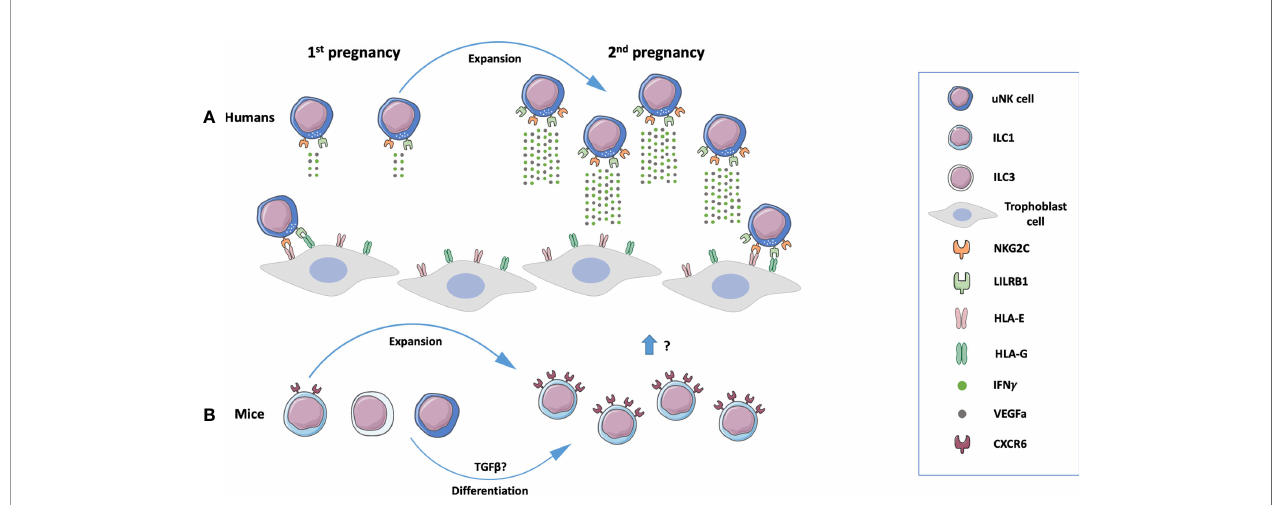
FIGURE 2 | Memory properties of innate lymphoid cells (ILCs) in human and mouse pregnancy. (A) A population of NKG2C hi LILRB1 hi uterine Natural Killer (uNK) cells present in the human endometrium expands during subsequent pregnancies and produces high amounts of interferon y (IFNy) and VEGFa, mediators that contribute to placental development. These processes are mediated by NKG2C and LILRB1 on uNK cells that recognize respectively HLA-E and HLA-G molecules expressed by trophoblast cells (13). (B) In mice, a population of innate lymphoid cells 1 (ILC1s) expand during subsequent pregnancies. uNK cells and ILC3 ’ s may be converted to ILC1s under the in fl uence of TGF b (15). Composed with images from: Smart Servier Medical Art